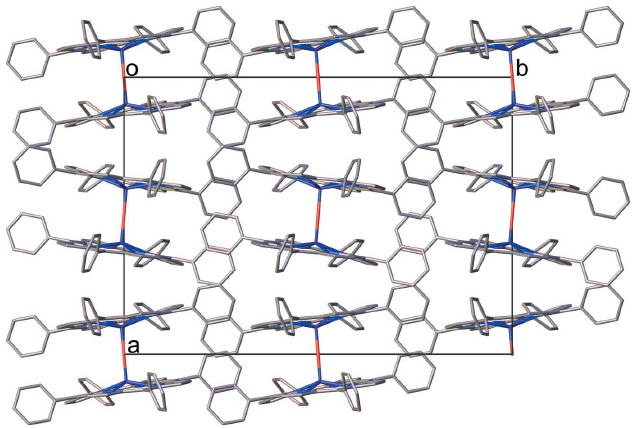
Figure 5 A view of the molecular packing in the crystal structure of the title compound, as seen in a projection along [001]. H atoms are omitted for